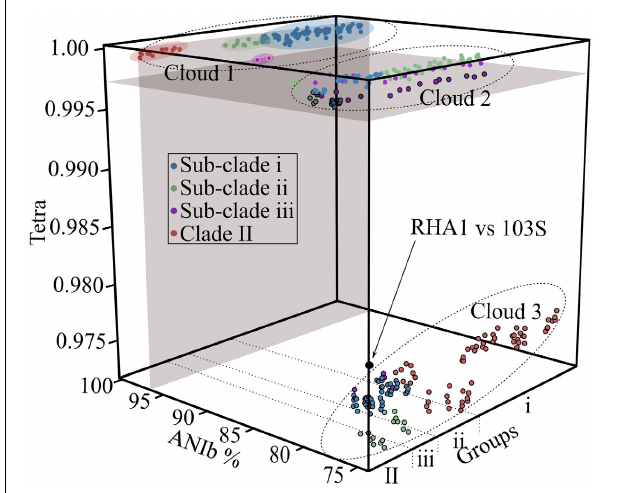
FIGURE 2 | Cloud plot of ANIb vs. TETRA for all possible pairwise comparisons. Average nucleotide identity (ANIb; x-axis) and tetranucleotide (TETRA; y-axis) usage patterns were calculated and plotted as a factor of isolate grouping (z-axis). All pairwise comparisons, including reciprocal comparisons are presented, with colors assigned based on the clade membership of the isolate being compared to. Gray colored areas demark 96% ANI and 0.997 TETRA thresholds. Clouds are demarcated by dotted lines. Circles with black borders are below the TETRA threshold. Circles with yellow borders (comparisons between isolates of sub-clade iii; purple) exceed the TETRA threshold but not the ANIb threshold. The black circle represents a comparison between R. jostii RHA1 and R. equi